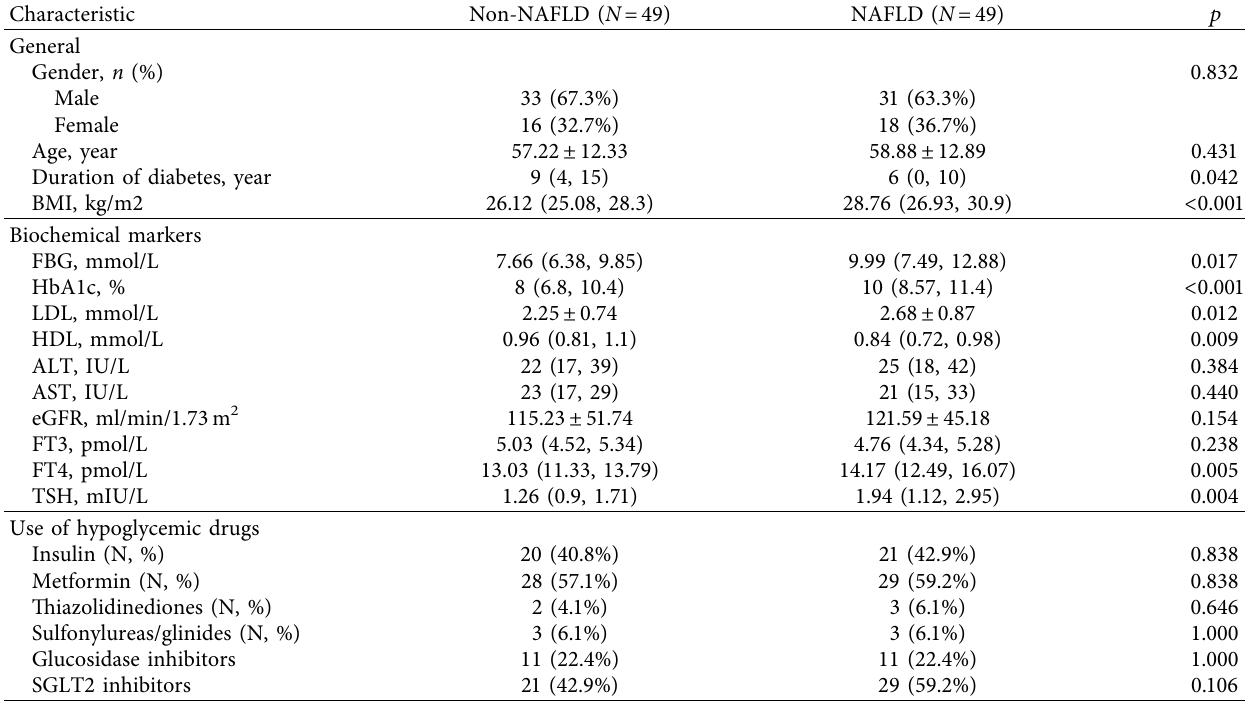
Table 1: Demographic and metabolic characteristics of study subjects.